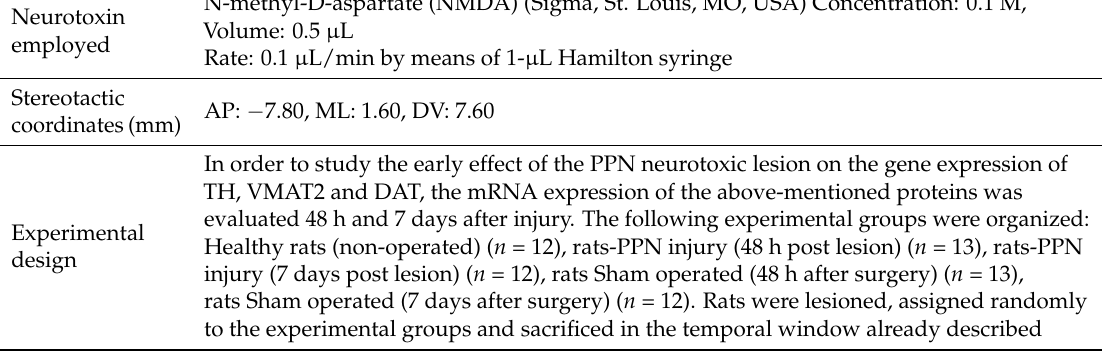
Table 1. Important aspects of the procedure followed to injure the right pedunculopontine nucleus of the rats. The injection coordinates of the neurotoxin were determined taking the Bregma point as the reference